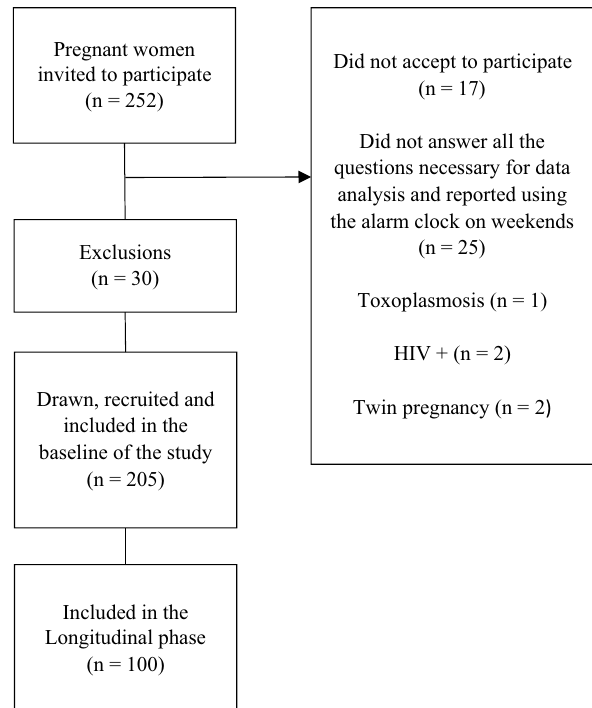
Figure 1. Study flowchart. Note : HIV human immuno-deficiency